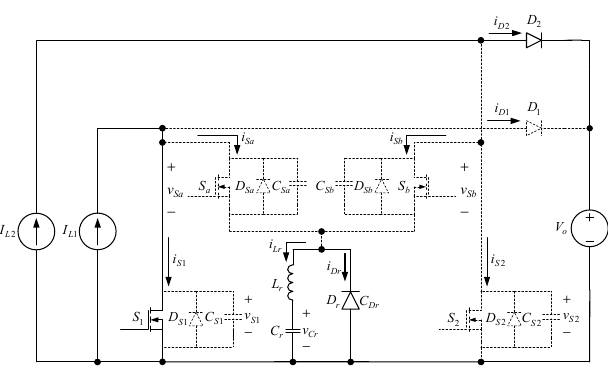
Figure 9. Current path in mode 6.